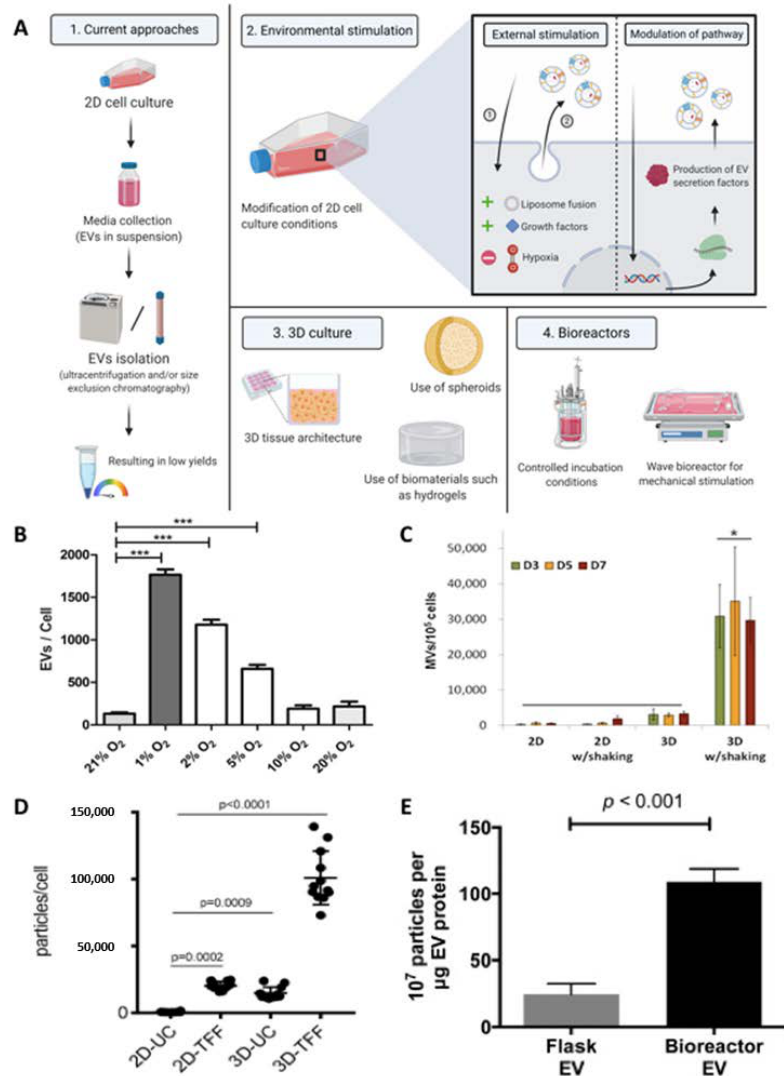
Figure 3. Methods of promoting EV scalability through environmental stimulation. ( A ) Schematic representation of strategies utilised to achieve scalability in EV manufacturing, such as the use of external stimulation, 3D culture platforms and bioreactor systems. ( B ) Hypoxic conditions enhanced the yield of EVs derived from endothelial cells compared to normoxic conditions. Reproduced with permission from [55], Elsevier, 2017. ***, p < 0.001. ( C ) 100-fold increase in EV quantity from MSCs cultured as spheroids with shaking during culture. Reproduced from [18], with permission from Springer Nature, 2018. *, p < 0.05. ( D ) Microcarrier-based 3D culture system combined with tangential flow filtration (3D-TIFF) enhanced MSCs yield 140-fold compared to cells culture in 2D conditions. Reproduced from [68], under the creative commons licence, 2018. ( E ) A hollow fibre bioreactor promoted EV yield 4-fold compared to 2D culture. Reproduced from [69], under the creative commons licence,